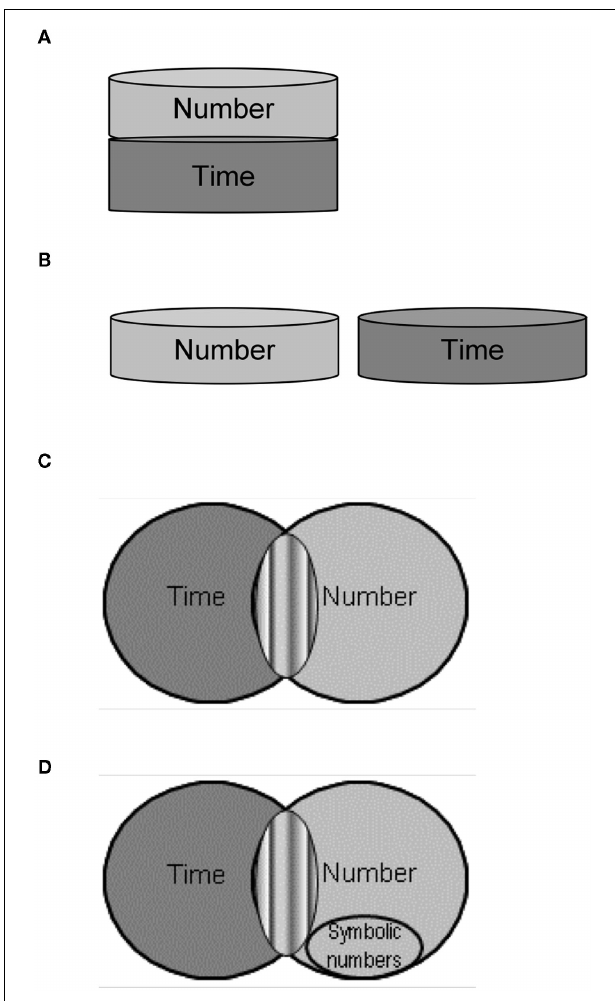
FIGURE 1 | Possible links between number and time. (A) Number and time fully share a single magnitude system, initially hypothesized as an “internal accumulator” representing information about either the numerosity or the duration of events/objects at one given time (e.g., Meck and Church, 1983); a single magnitude system would predict no dissociations between number and time and no interactions between them. (B) Number and time are fully independent, such that magnitude information is analyzed according to metrics unique to each dimension and therefore dissociations but no interactions are expected between dimensions (e.g., Murphy, 1996, 1997; Agrillo et al., 2010; Dehaene and Brannon, 2011). (C) Number andTime partly share a magnitude system (or possibly operational mechanisms depicted in gray stripes) and are also implemented by dimension-specific processes, such that interactions are possible as well as dissociation among dimensions if the dimension-specific processes are selectively impaired (ATOM,Walsh, 2003; Cantlon et al., 2009; Cappelletti et al., 2009, 2011). (D) Symbolic numbers may recycle systems dedicated to number or numerosity processing but are unlikely to recycle systems dedicated to continuous quantity processing like